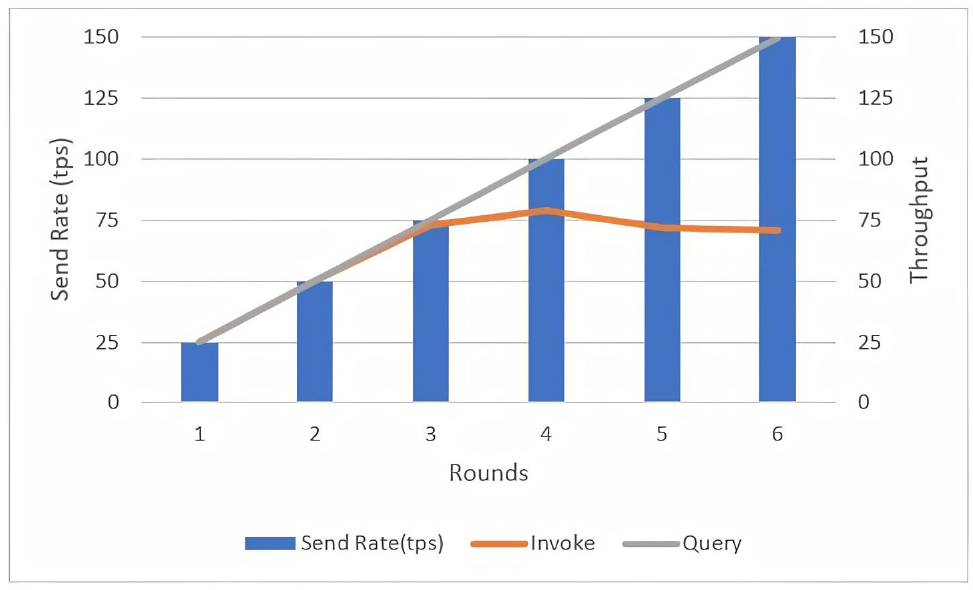
Figure 5. Impact of send rate on network transaction